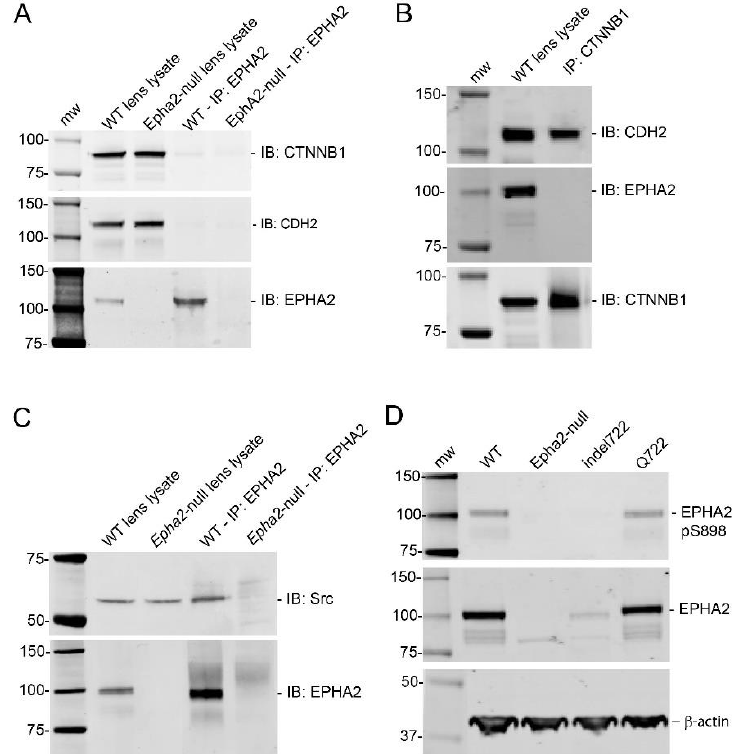
Figure 7. EPHA2 complex formation and phosphorylation status in the lens. ( A – C ) Immunoprecipitation analysis of wild type lenses (P21) showing that EPHA2 forms trace complexes with CTNNB1 but not with CDH2 ( A ) and that CTNNB1 complexes strongly with CDH2 but not with EPHA2 ( B ), whereas EPHA2 forms complexes with Src ( C ). ( D ) Immunoblot showing EPHA2 serine 898 phosphorylation (pS898) levels detected in wild-type and Epha2 -mutant lenses.